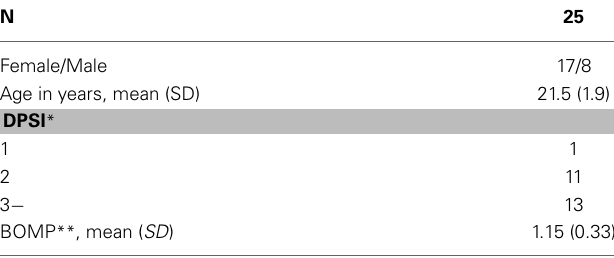
Table 4 | Subject demographics and their periodontal health.